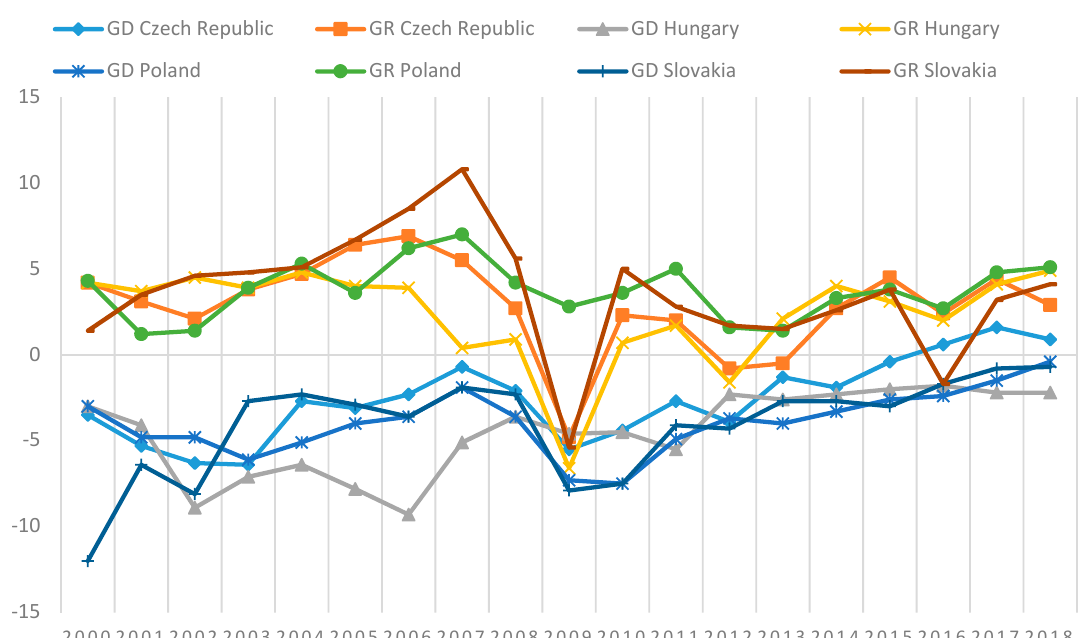
Figure 5. Central and Eastern European countries’ GD percentage of GDP versus growth rate percentage change from previous year, 2000–2018; Source: Eurostat.